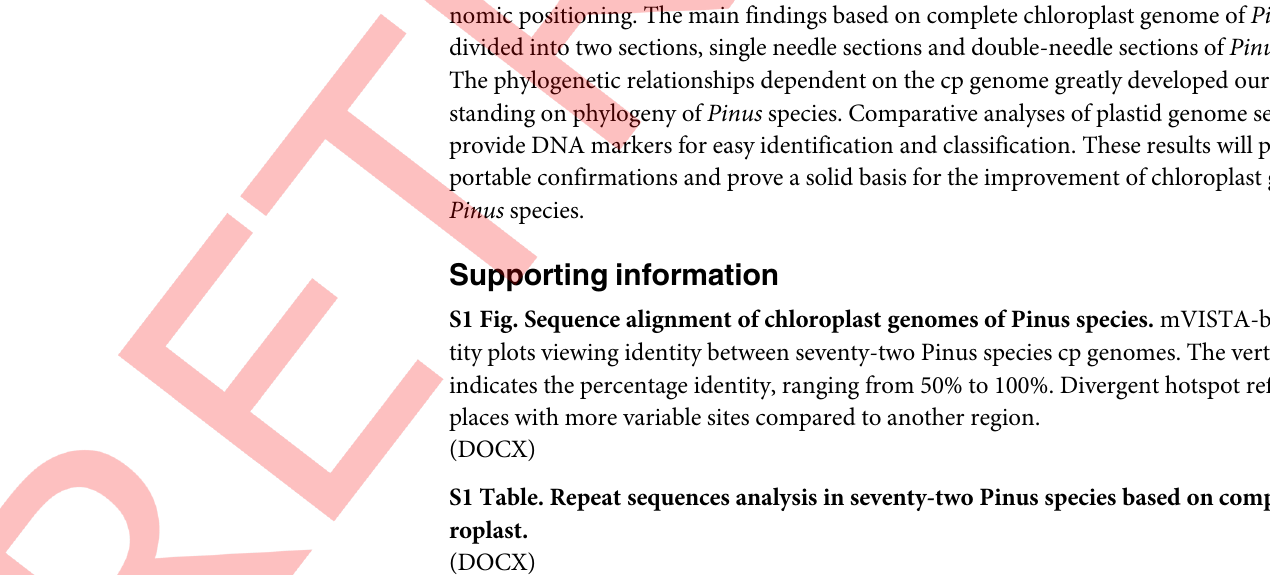
S1 Table. Repeat sequences analysis in seventy-two Pinus species based on complete